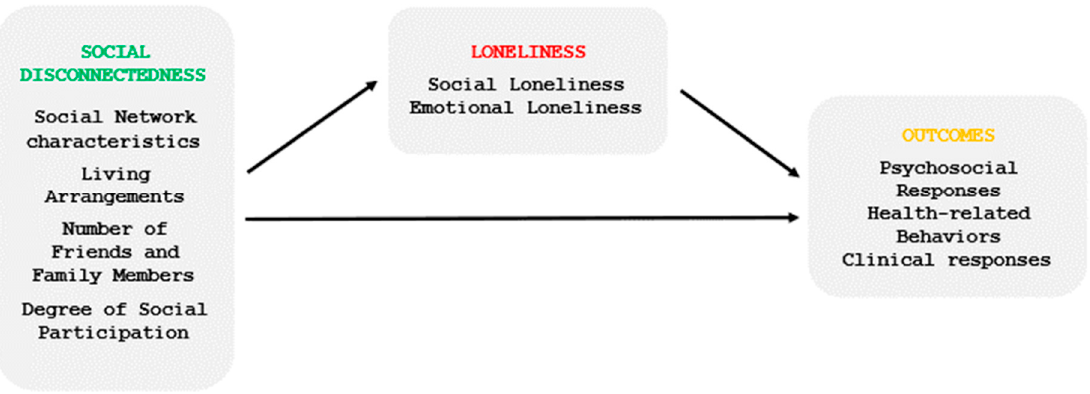
Figure 3. Pictorial representation of the direct and mediating effects of social disconnectedness on health outcomes.